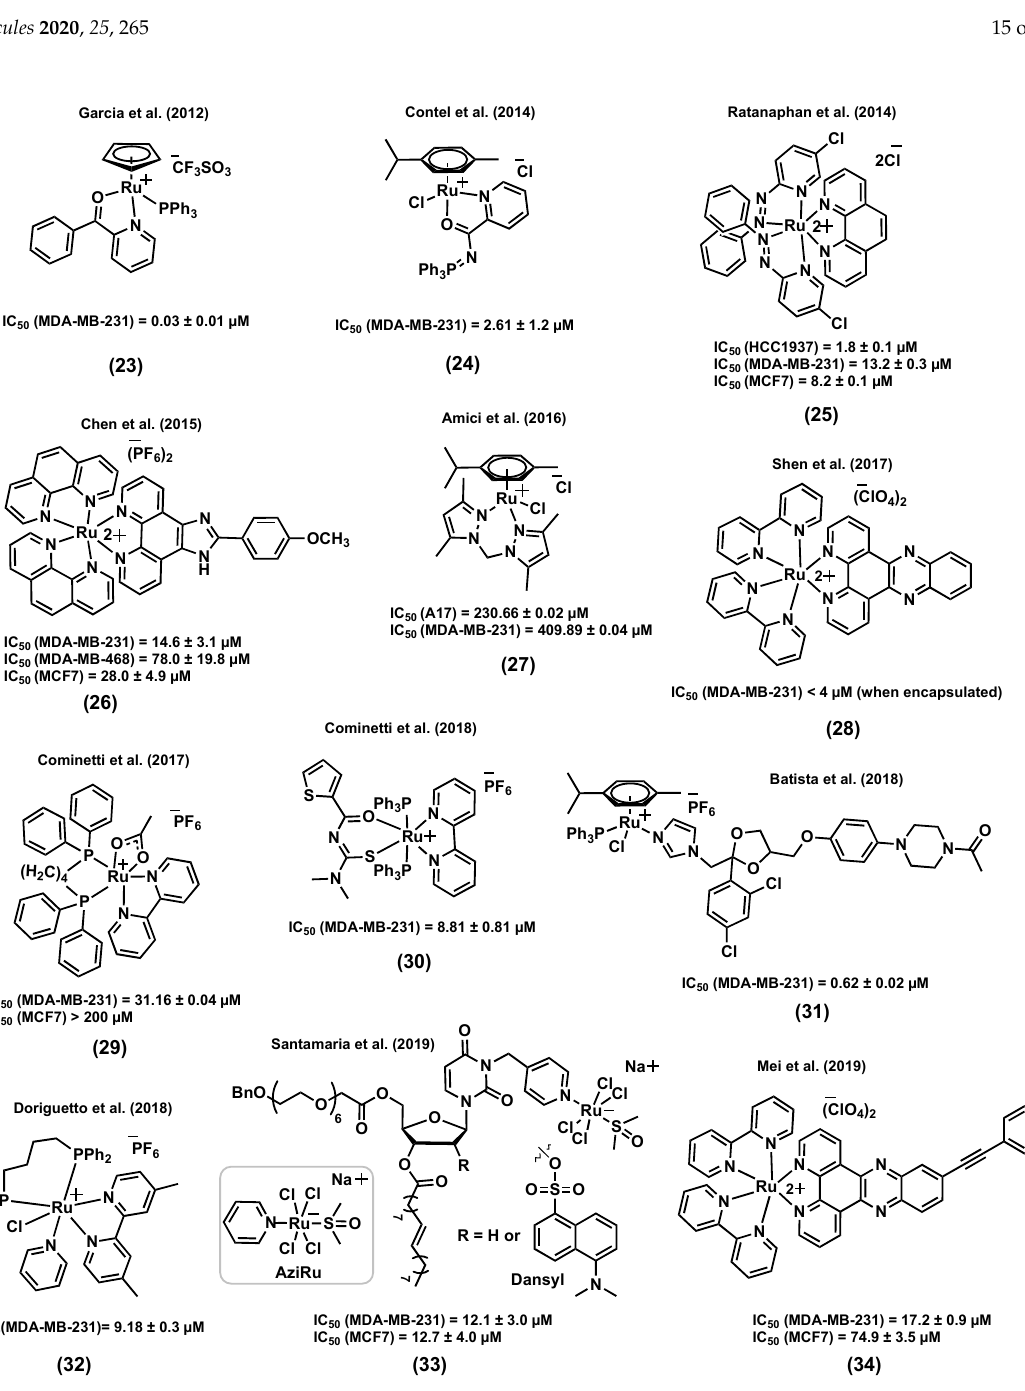
Figure 10. Other ruthenium complexes for triple negative breast cancer (TNBC) treatment.